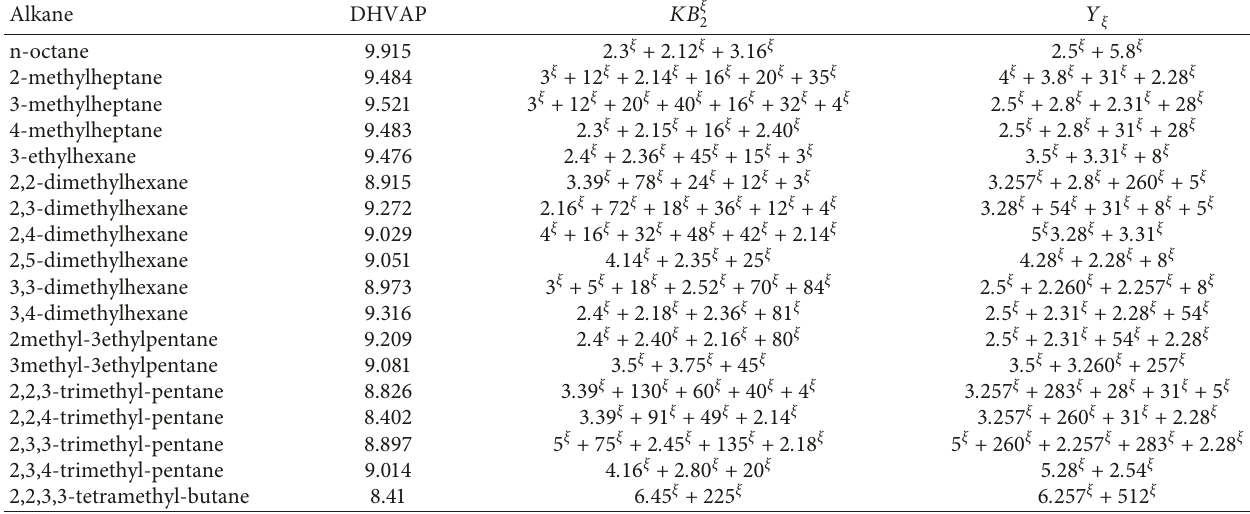
Table 9: Experimental values of DHVAP and the corresponding values of generalized form of second Kulli–Basava index and generalized power-sum-connectivity index of octane isomers.